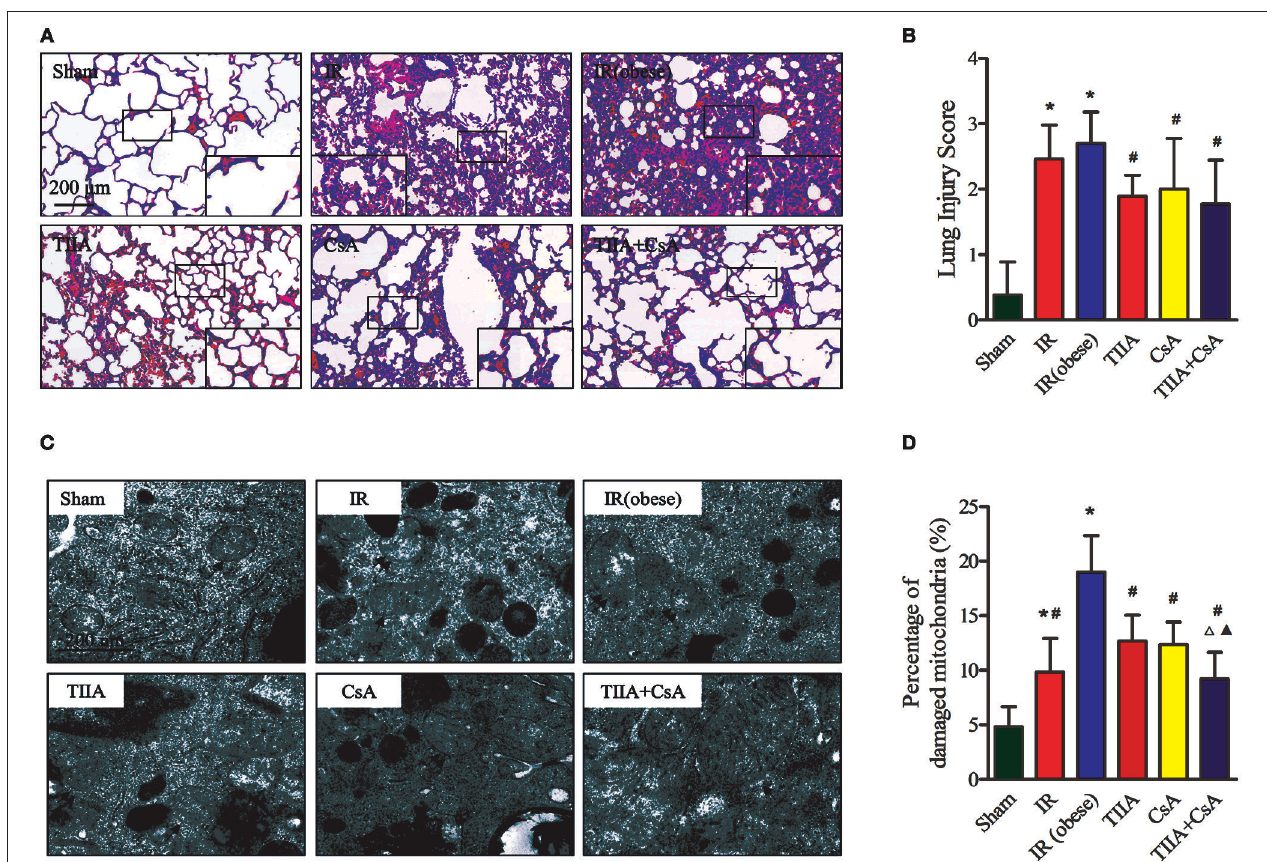
FIGURE 2 | Tanshinone IIA (TIIA) + cyclosporine A (CsA) preserved lung architecture in renal ischemia-reperfusion (IR)-induced lung injury. Rats were pretreated with TIIA alone or in combination with CsA followed by removing the right kidney and clamping of the left renal artery for 30min and reperfusion for 24h. Sham rats were used as control. Representative photomicrographs of lung histology (A) , the scale bars represent a length of 200 µ m on histology, and lung injury scores (B) were evaluated under different conditions. The scale bars represent a length of 200 µ m on histology. Electron microscope pictures ( × 40,000) of rat lung tissue after renal ischemia-reperfusion (IR). Abnormal mitochondrial (paired black arrow) morphology showed mitochondrial membrane rupture or swellings; normal mitochondrial (single black arrow) morphology type showed smooth mitochondrial membrane and smooth and distinct inner carinulae (C) , and percentage of damaged mitochondria (D) . Data are shown as mean ± SD. * p < 0.05 vs. sham group, # p < 0.05 vs. IR (obese) group, 1 p < 0.05 vs. TIIA group, N p < 0.05 vs. CsA